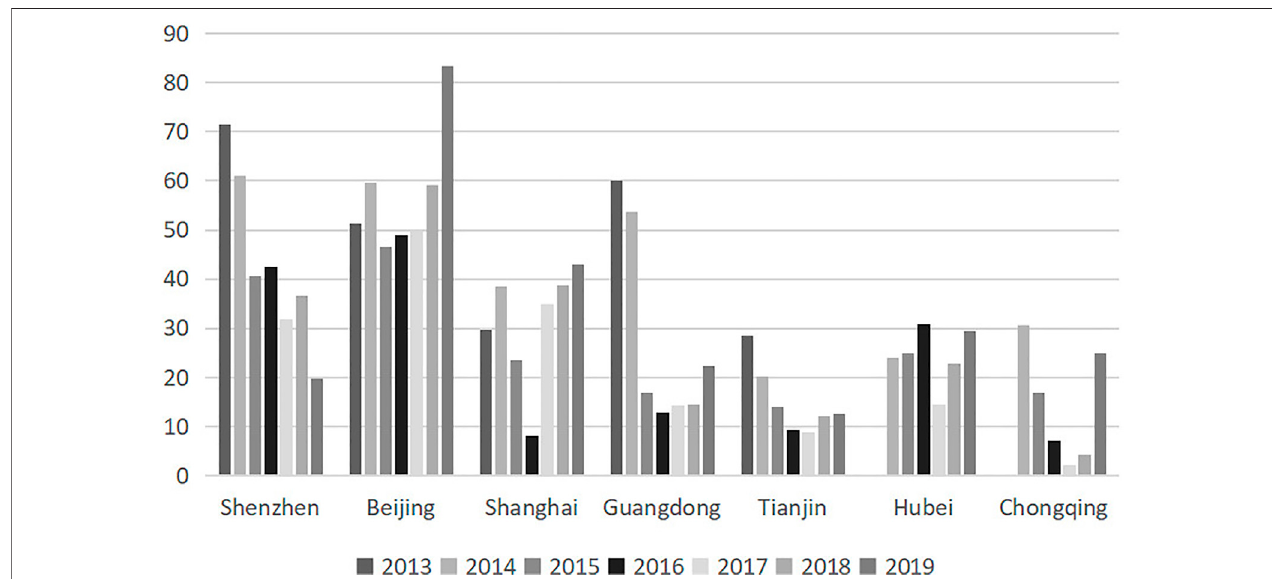
FIGURE 2 | Carbon emissions trading prices of the seven pilots 2013 – 2020. Source: china carbon emissions trading network.